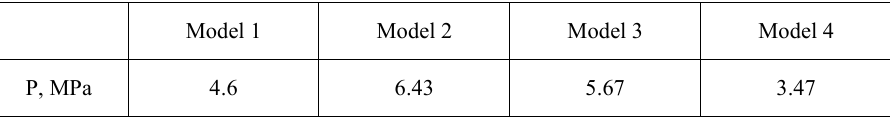
Table 2. The greatest pressure occurs in the two nearest